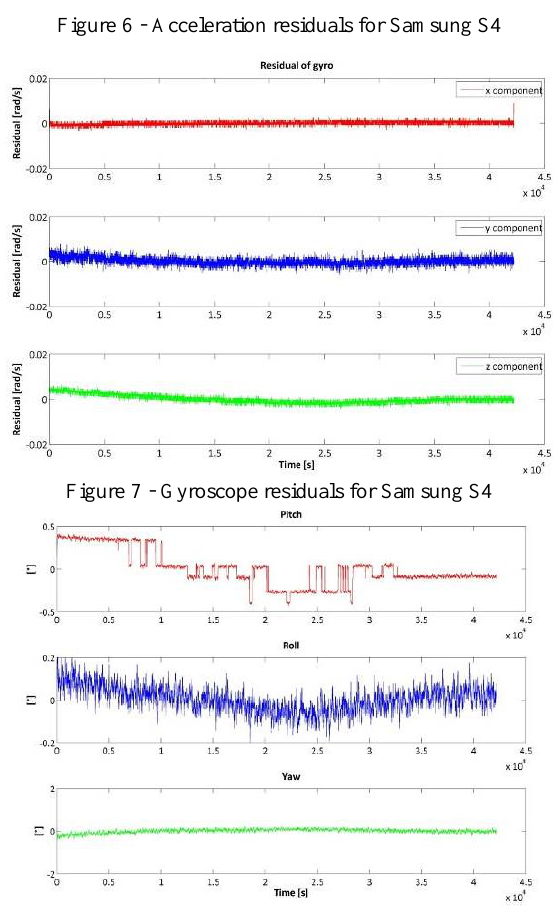
Figure 8 - Roll, Pitch and Yaw stability for Samsung